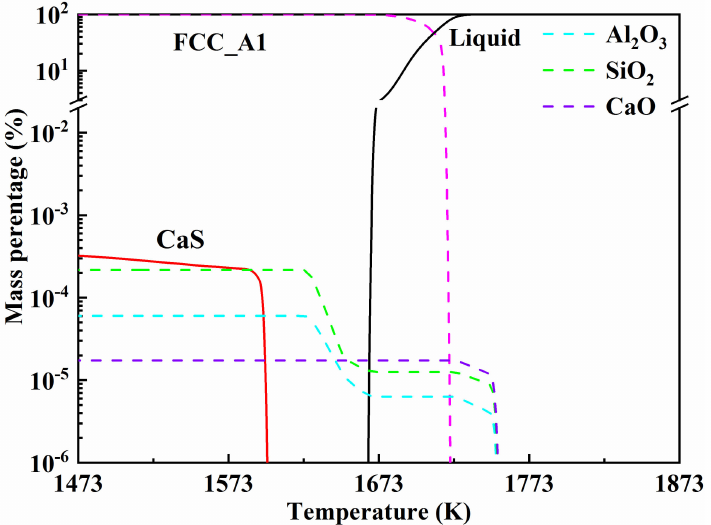
Figure 8. Equilibrium precipitation of inclusions during solidification of 15-5PH stainless (14.5%Cr- 5.2%Ni-3%Cu-0.7%Mn-0.4%Si-0.3%Mo-0.2%Nb-0.05%C-Fe) with the VC-onset